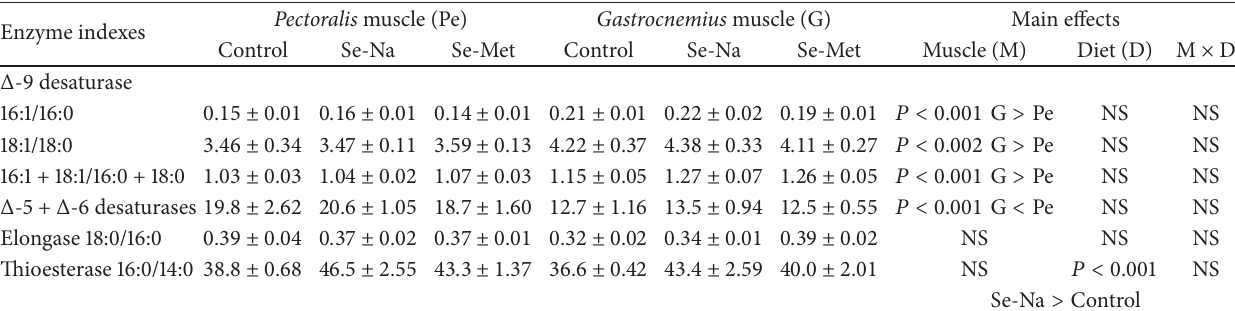
Table 4: Enzymes indexes of fatty acid metabolism estimated on the basis of fatty acid composition of Pectoralis and Gastrocnemius muscles of chickens supplemented in diet with inorganic (Se-Na) or organic (Se-Met) selenium. Pectoralis muscle (Pe) Gastrocnemius muscle (G) Enzyme indexes Control Se-Na Se-Met Control Se-Na